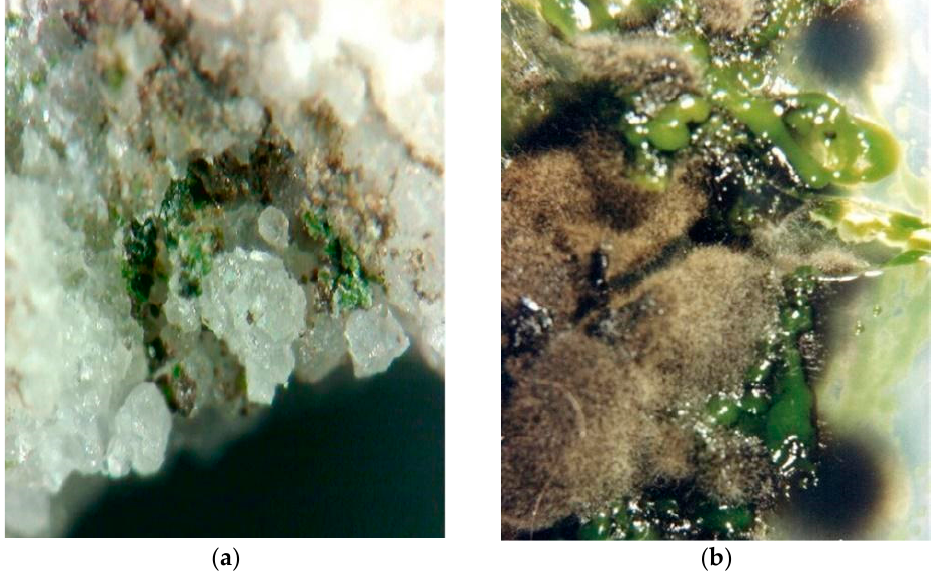
Figure 2. Close association between MCF and phototrophic microorganisms. ( a ) Association seen directly on a marble sample. Magnification 400X and ( b ) after growth in the isolation medium PDA: Chlorella -like alga and Coniosporium apollinis MC 728. Magnification 80X. Black fungi are currently classified in the Phylum of Ascomycota in the Class of Dothideomycetes and Eurotiomycetes, mainly in the order of Capnodiales, Dothideales,